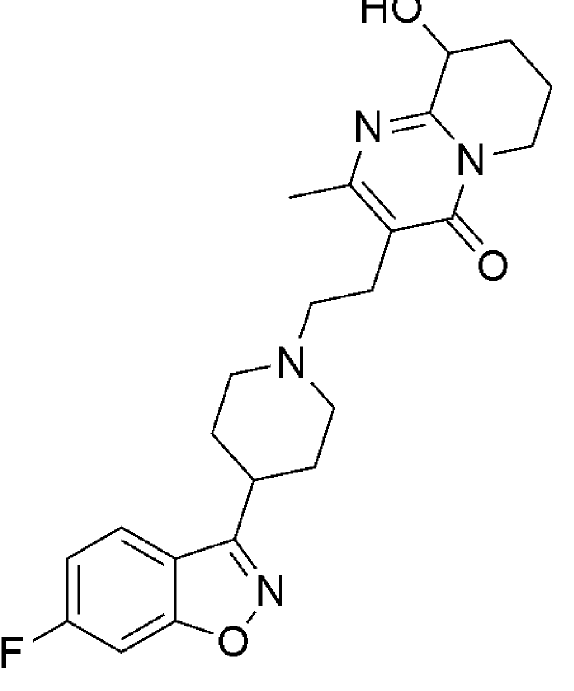
Figure 1. Chemical structure of paliperidone.